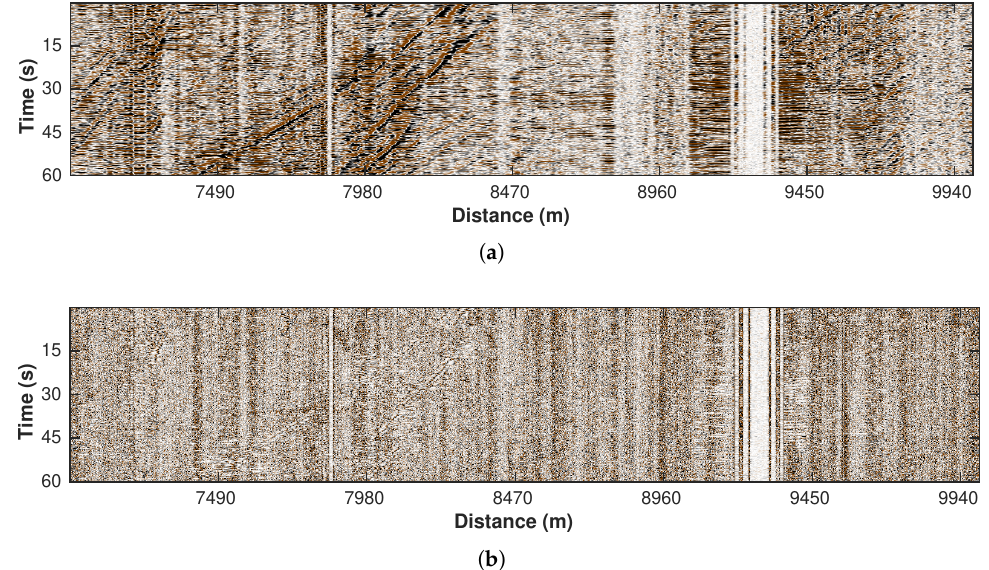
Figure 10. Processing results using local F-K filter with hard threshold. ( a ) Filtered data. ( b ) Removed noise